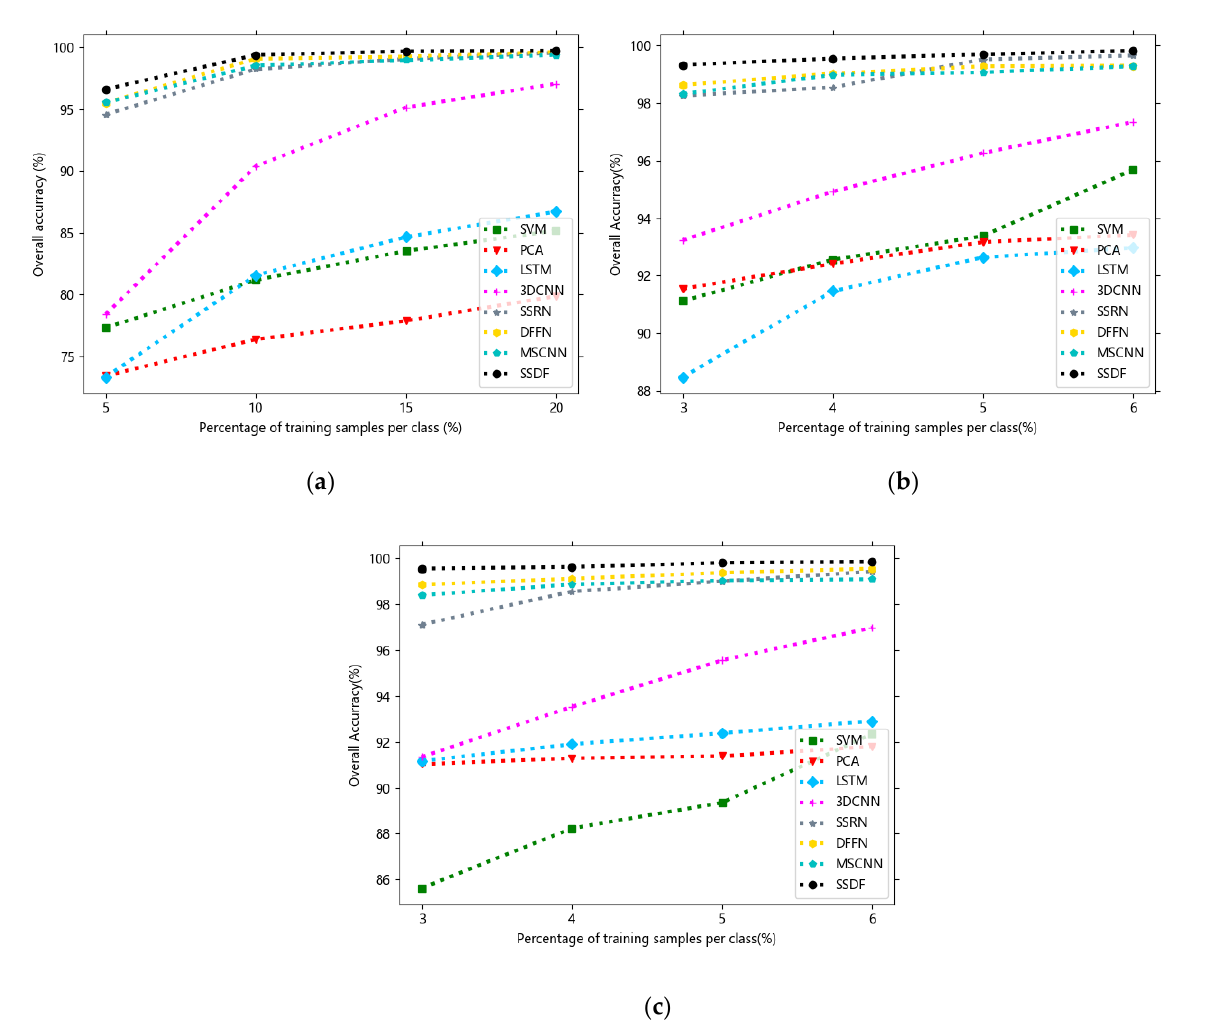
Figure 12. The curves of overall accuracies versus different percentages of training samples obtained by different methods on three datasets: ( a ) Indian Pines dataset, ( b ) Pavia University dataset, and ( c ) Salinas scene dataset.